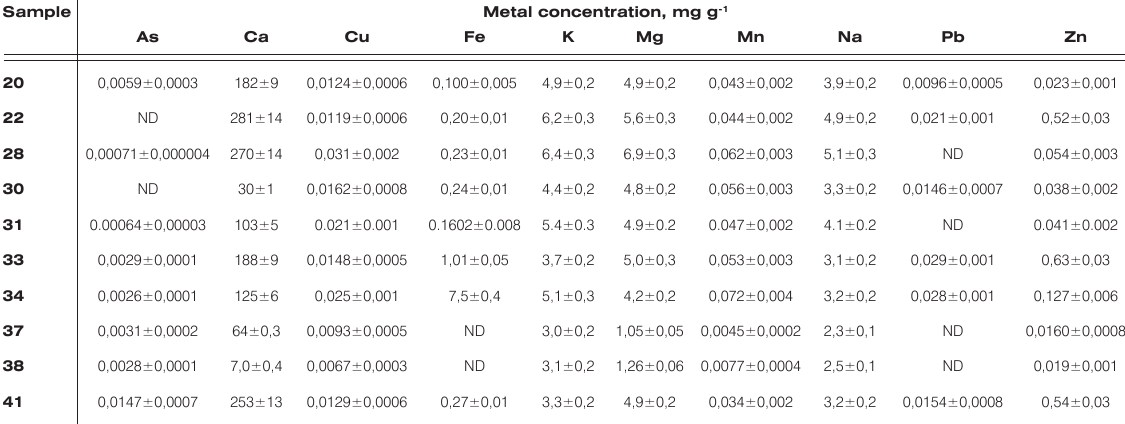
Table 2. Chemical analysis data obtained by AES (ND – non detectable).